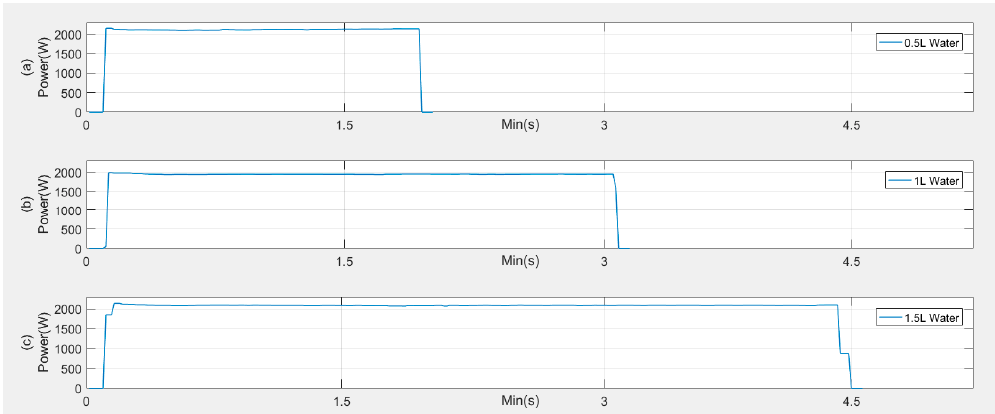
Figure 14. The power consumption curve of the kettle for ( a ) 0.5 L water, ( b ) 1 L water, and ( c ) 1.5 L water.